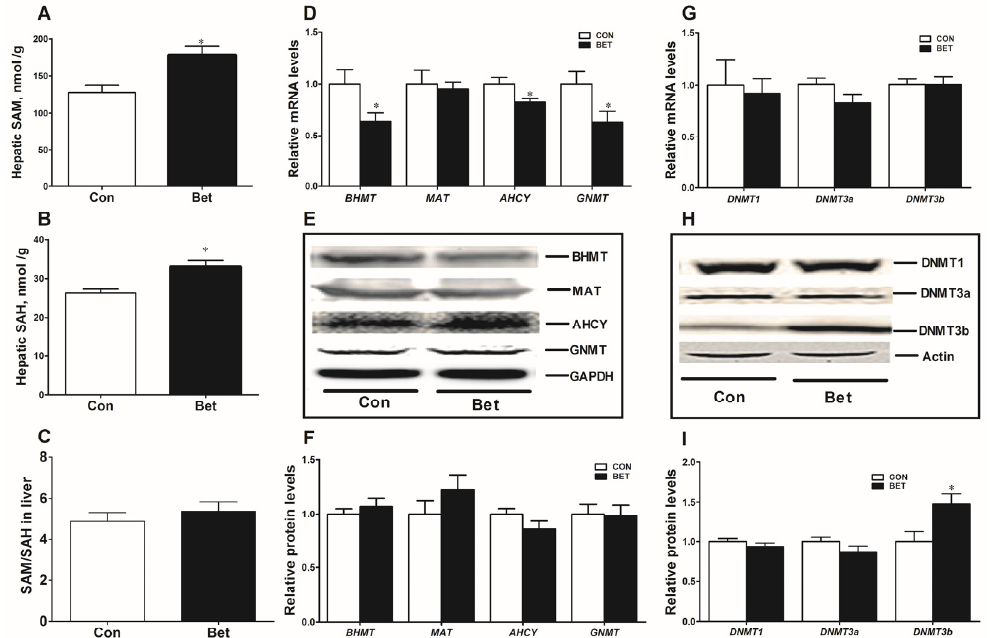
Figure 2. Concentration of hepatic S -adenosylmethionine (SAM) ( A ) and S -adenosylhomocysteine (SAH) ( B ); as well as the ratio of hepatic SAM to SAH ( C ) in weaning piglets; hepatic mRNA abundance ( D ); and Western blotting analysis plus graphic summary ( E , F ) of proteins expression involved in methionine metabolic cycle; DNA methyltransferases including DNMT1, DNMT3a, and DNMT3b expression at mRNA ( G ) and protein level ( H , I ) in the liver of weaning piglets. Values are means ± SEM, n = 8. Different from control, * p < 0.05.